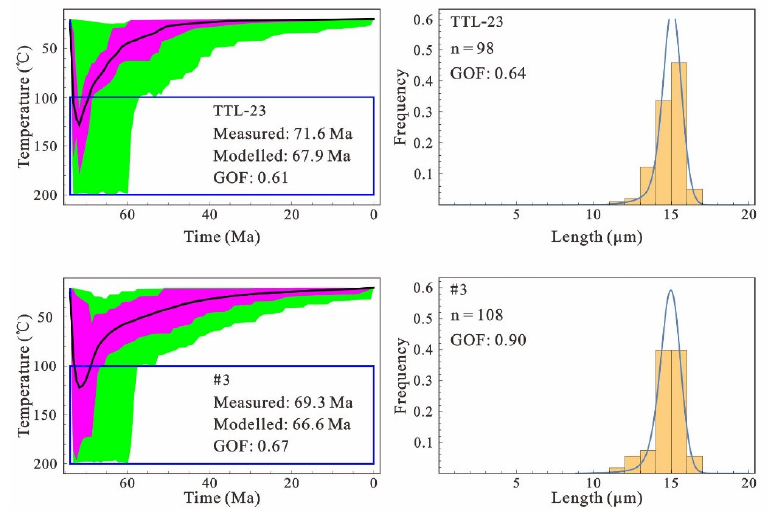
Figure 5. Thermal history models of samples TTL-23 and #3. The Low-T Thermo computer code [34] was used for the modelling. The 1,000,000 t-T paths were randomly generated using the Monte Carlo method. The blue indicates the substantial range used to search for reheating. The mean of all good t-T paths (i.e., goodness-of-fit (GOF) ≥ 0.5) was calculated and assumed to be the most likely t-T path of the sample. The blue boxes were defined to constrain the reheated model during the modeling moderation. The black solid lines represent the mean thermal histories (MTHs) used as the final thermal history modelling result. The magenta areas define the envelopes of good fit (GOF ≥ 0.5). The green areas define the envelopes of acceptable fit (GOF ≥ 0.05). 5. Discussion The zircon U-Pb dates of the rhyolite porphyry samples from country rock were con- centrated in the late Cretaceous. In contrast, the zircon U-Pb dates of the sedimentary samples from country rock ranged from early Cretaceous, Triassic and early Paleozoic to Proterozoic. The zircon U-Pb dates of the fault-zone samples were also dispersed, ranging from late Cretaceous, late Jurassic–early Cretaceous and early Paleozoic to Proterozoic. This implies that the source rock of the fault breccia samples was most likely rhyolite porphyry and sedimentary rock. The late Cretaceous zircon U-Pb dates of the three rhyolite porphyry samples were concentrated in the range from 91.8 to 74.9 Ma, and the late Cretaceous zircon U-Pb dates of the three fault breccias were concentrated in the range from 93.5 to 73.9 Ma. Combining these two groups, it can be inferred that there was multiple-stage magmatic activity or an extended period of volcanic activity in the late Cretaceous from 93.5 to 73.9 Ma. Therefore, the entire zircon U-Pb dataset was used to obtain a maximum age for the faulting since the faulting occurred after the deposition of the rhyolite porphyry; i.e., the faulting oc- curred after 73.9 Ma. The AFT results, which indicated similar AFT dates (around 70 Ma), unimodal dis- tribution of AFT confined lengths (Figure 4) and high χ 2 values for AFT grain dates (Table 1), implied that the three fault breccia samples likely underwent complete annealing with the rhyolite porphyry around 70 Ma. This also implied that the fault breccia samples likely formed before ~70 Ma. Both friction and hydrothermal infilling are possible reason for this reset, but further research is needed. Based on the reheating model, the thermal history modelling results of samples TTL- 23 and #3 showed rapid cooling during 70–65 Ma and slow cooling during 65–0 Ma. The cooling trends of both samples were highly consistent. One possible reason is that the rock from samples TTL-23 and #3 underwent the same cooling history after the forming of the